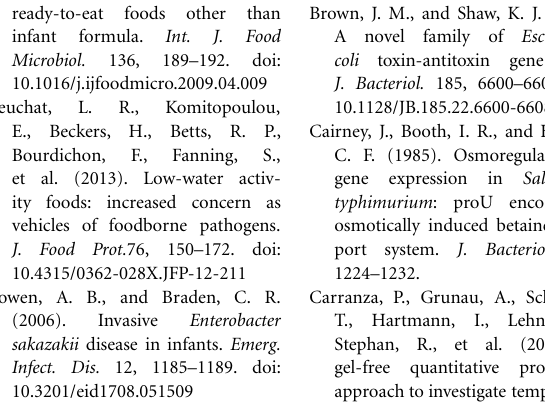
Table S5 | Annotated plasmid clusters of three complete genome, which include pSP291-1, pSP291-2, and pSP291-3 of C. sakazakii SP291, pESA2 and pESA3 of C. sakazakii ATCC BAA-894, as well as pCTU1, pCTU2, and pCTU3 of C. turicensis z3032. Plasmid group 1 : pSP291-1, pESA3, and pCTU1; plasmid group 2 : pSP291-2 and pCTU3. Table S6 | Numerical data for all 20PM plates of C. sakazakii SP291 and C. sakazakii ATCC BAA-894, along with the phenotype differences (greater than 20,000 ± 1,800 unit) generated by Omnilog® software. Table S7 | Genes assigned to defined bacterial sub-systems and their distribution among these functional categories for C. sakazakii SP291 along with other three completed genome, C. sakazakii ATCC BAA-894, C. sakazakii ES15, and C. turicensis z3032.